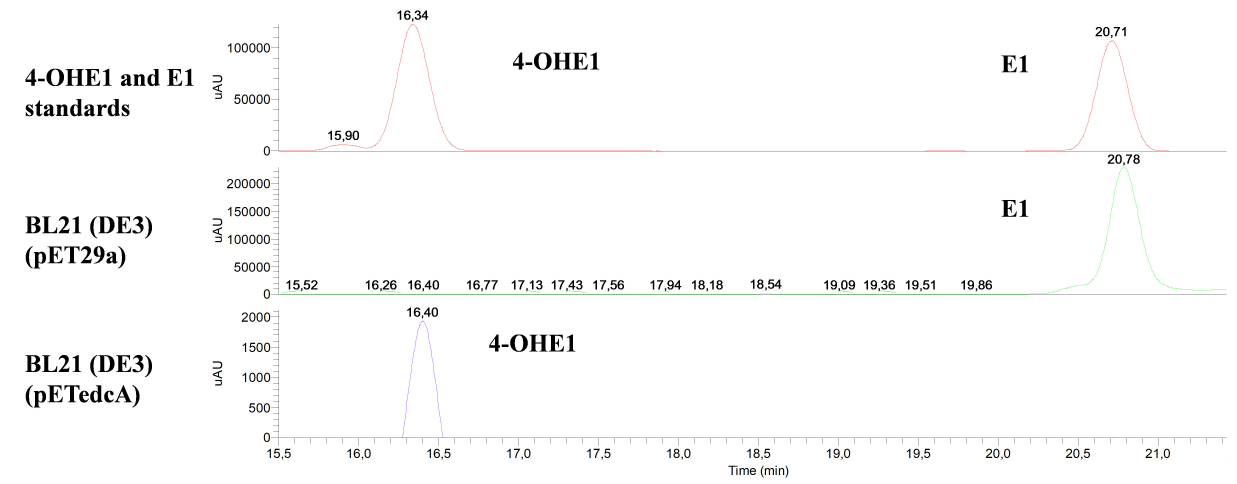
(pSEVA237-Pb-edcAB) strain corresponds to a compound of m / z 300, consistent with pyridinestrone acid (Chen et al.,